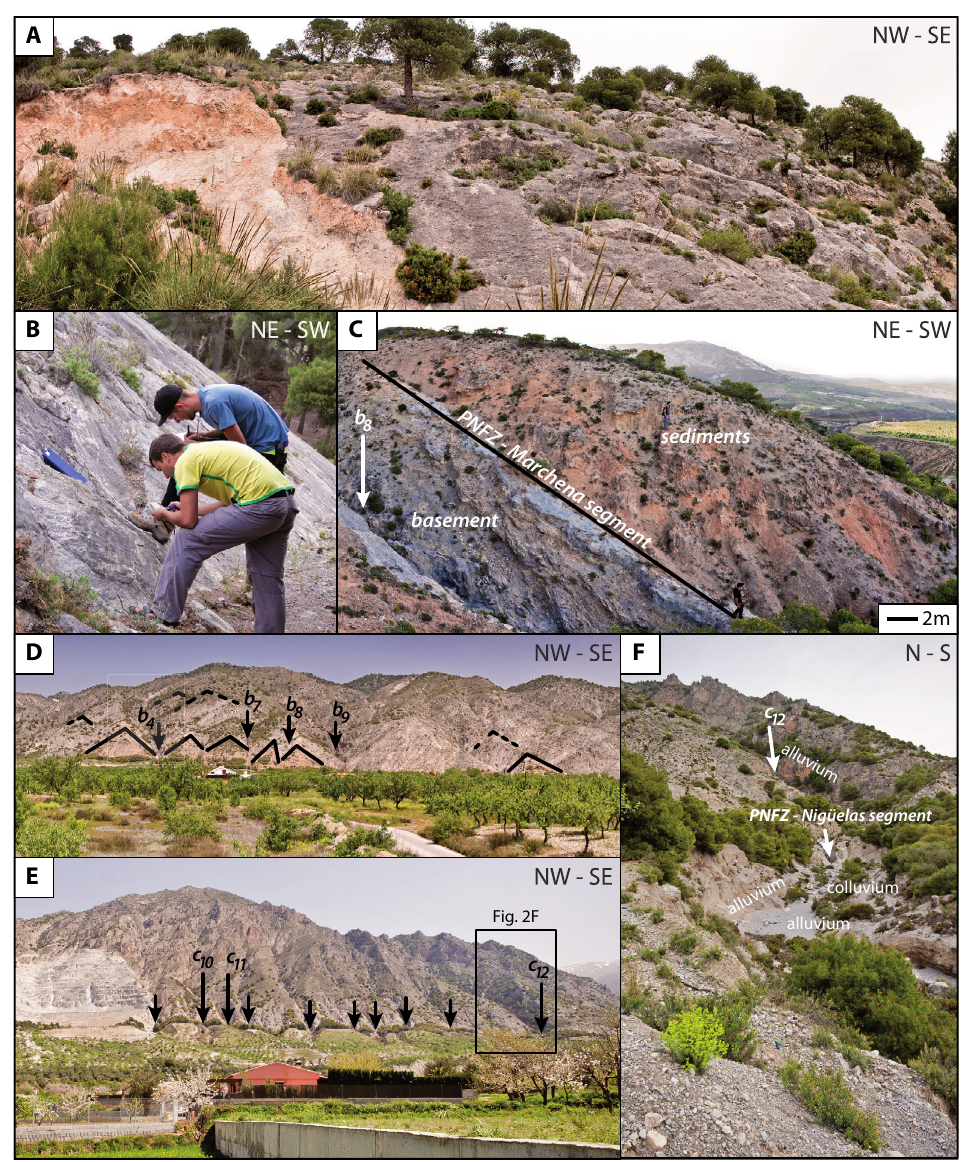
Figure 2. Field photographs from the study area. Orientation is indicated by the cardinal directions, view direction is plotted in Figure 1. [A] Bedrock fault scarp with different levels of degradation in the south-eastern part of the Padul segment. [B] Measuring dips and dip directions at the north-western part of the Padul segment. [C] Contact of the Alpujárride basement fault and the Neogene and Quaternary sedimentary overlay in channel b (see [D] for location). [D] Different generations of triangular facets at the Marchena segment (solid black lines: youngest 8 facets; dashed black lines: older generations). Black arrows indicate the position of channels b , c and c ) at the Dúrcal segment. [F] Detailed view of an incised channel c nels (black arrows, especially channels c 10 11 12